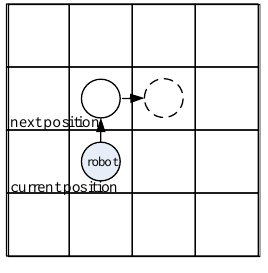
Figure 3. Raster